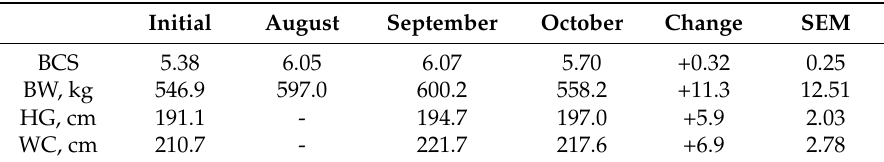
Table 4. Means and change (beginning–October) of body condition score (BCS; score 1–9), body weight (BW, kg), heart girth circumference (HG, cm) and waist circumference (WC, cm) of the horses ( n = 20) in Ypäjä semi-natural pasture during the study